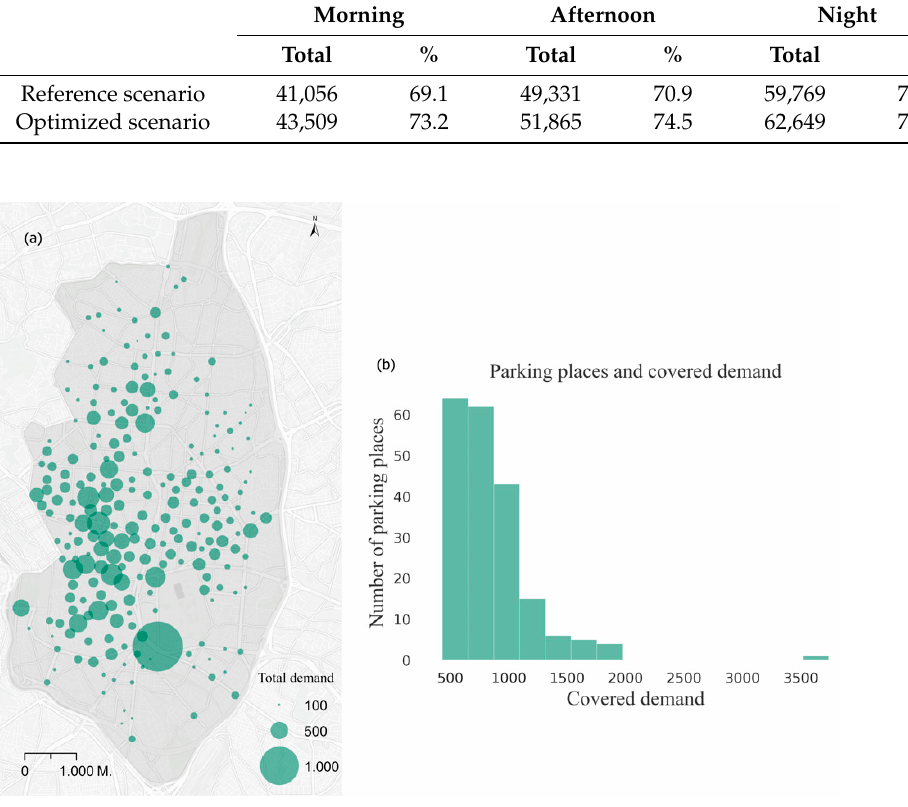
Figure 11. Optimized scenario: ( a ) Distribution of final parking spaces with the allocated demand. ( b ) Covered demand distribution by parking places. Table 7. Demand covered by parking spaces in each of the time bands by model. Morning